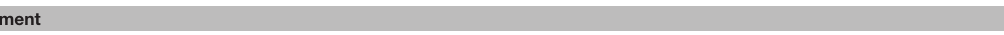
TABLE 4 | Description of Measures in